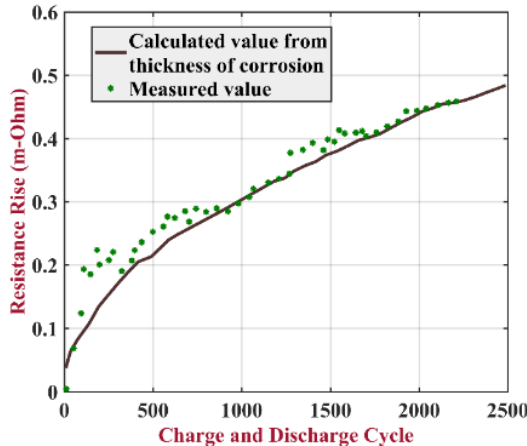
Figure 32. Graph of the internal resistance versus depth of discharge of NaS at various temperatures [19].